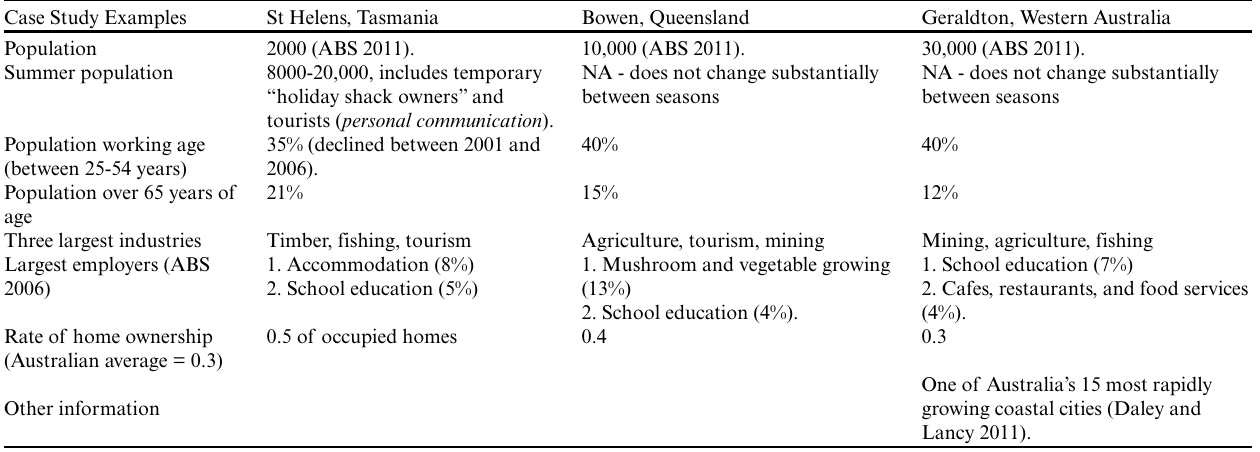
Table 1 . General information and demographics (ABS 2011) for three case study areas. NB: Main industries are based on the list provided by the Australian Bureau of Statistics for the 2011 census.